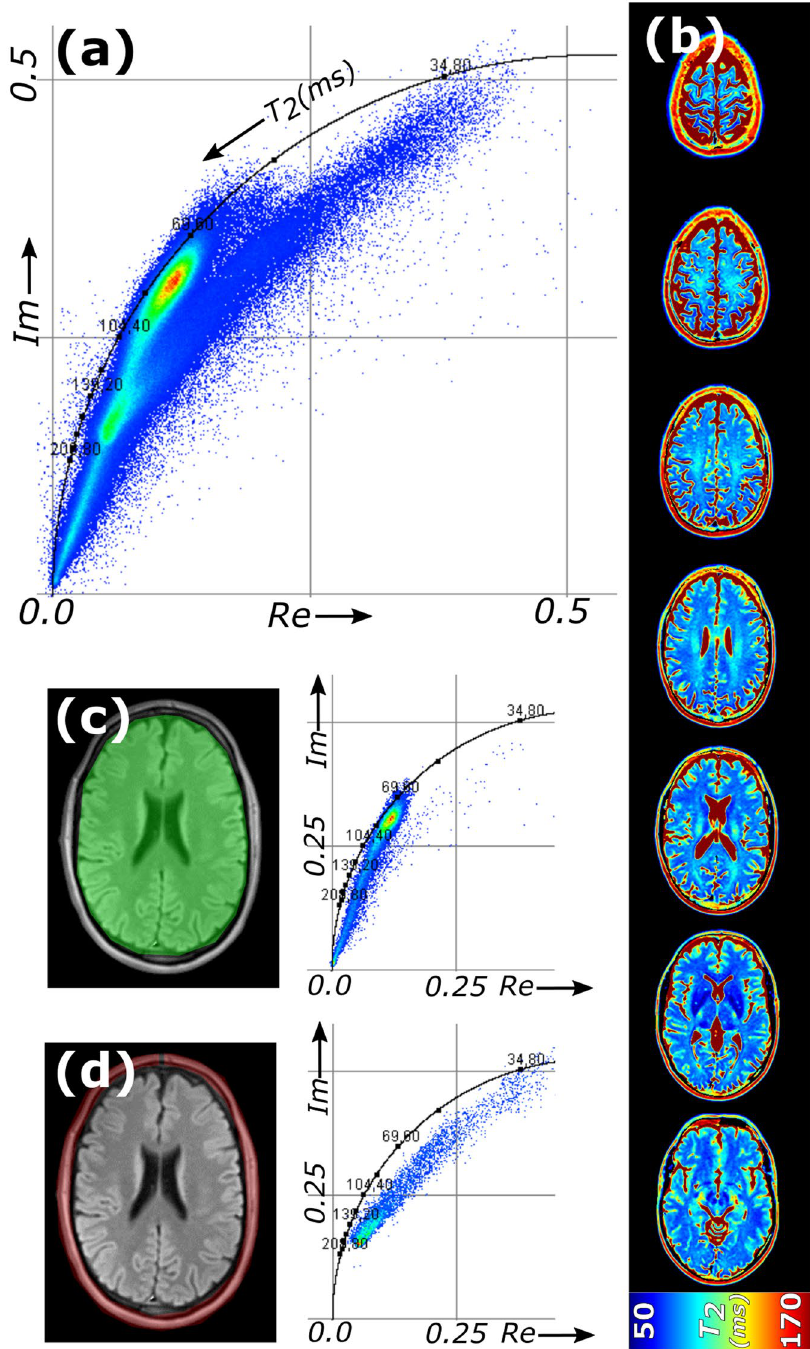
Figure 3. Phasor analysis of a quantitative T 2 MRI dataset of an in vivo human head. ( a ) Phasor plot of a multislice 2D quantitative T 2 dataset of a human brain (10 echoes); ( b ) T 2 maps of a representative subset of slices (full set available as Supplementary Video 1); spatial segmentation followed by phasor analysis of ( c ) the brain tissue and ( d ) the